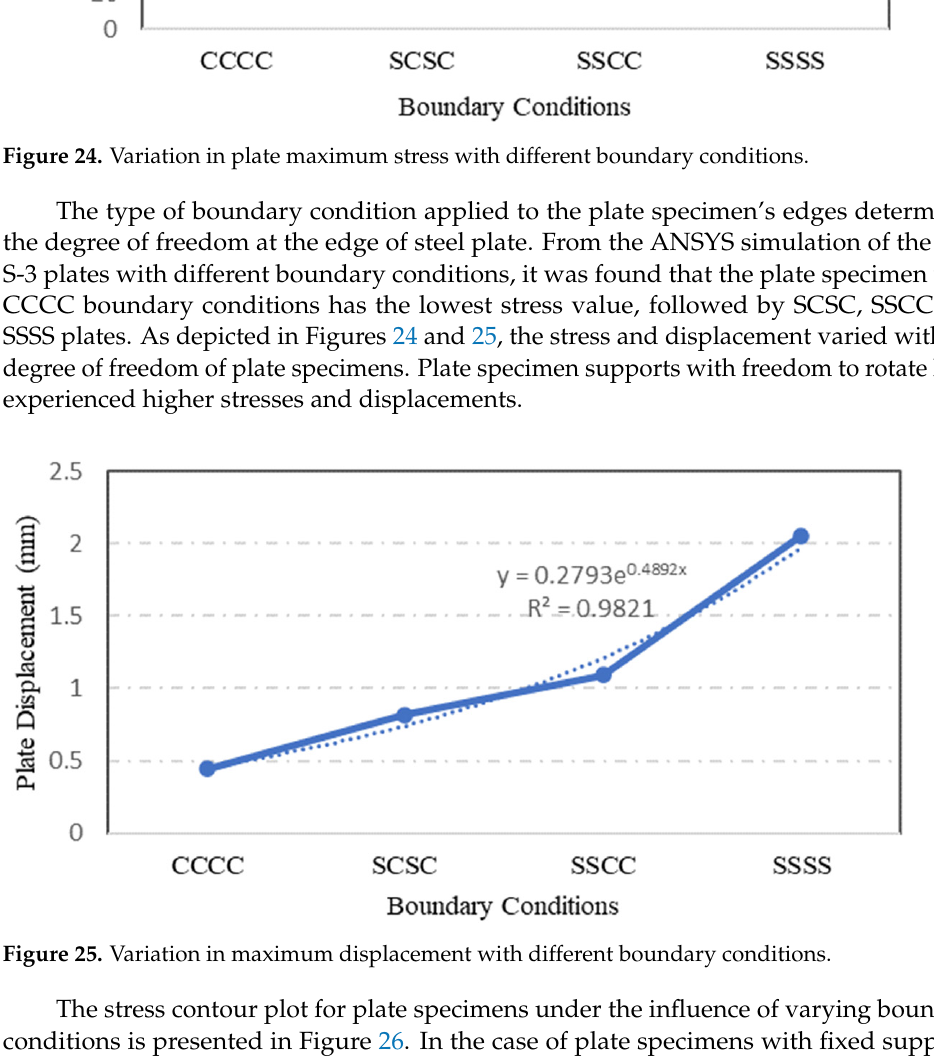
Figure 25. Variation in maximum displacement with different boundary conditions. The stress contour plot for plate specimens under the influence of varying boundary conditions is presented in Figure 26. In the case of plate specimens with fixed supports, the applied pressure was distributed and carried out by the supports and plate edges. The maximum stress was concentrated at the edges of the plate near the fixed support.